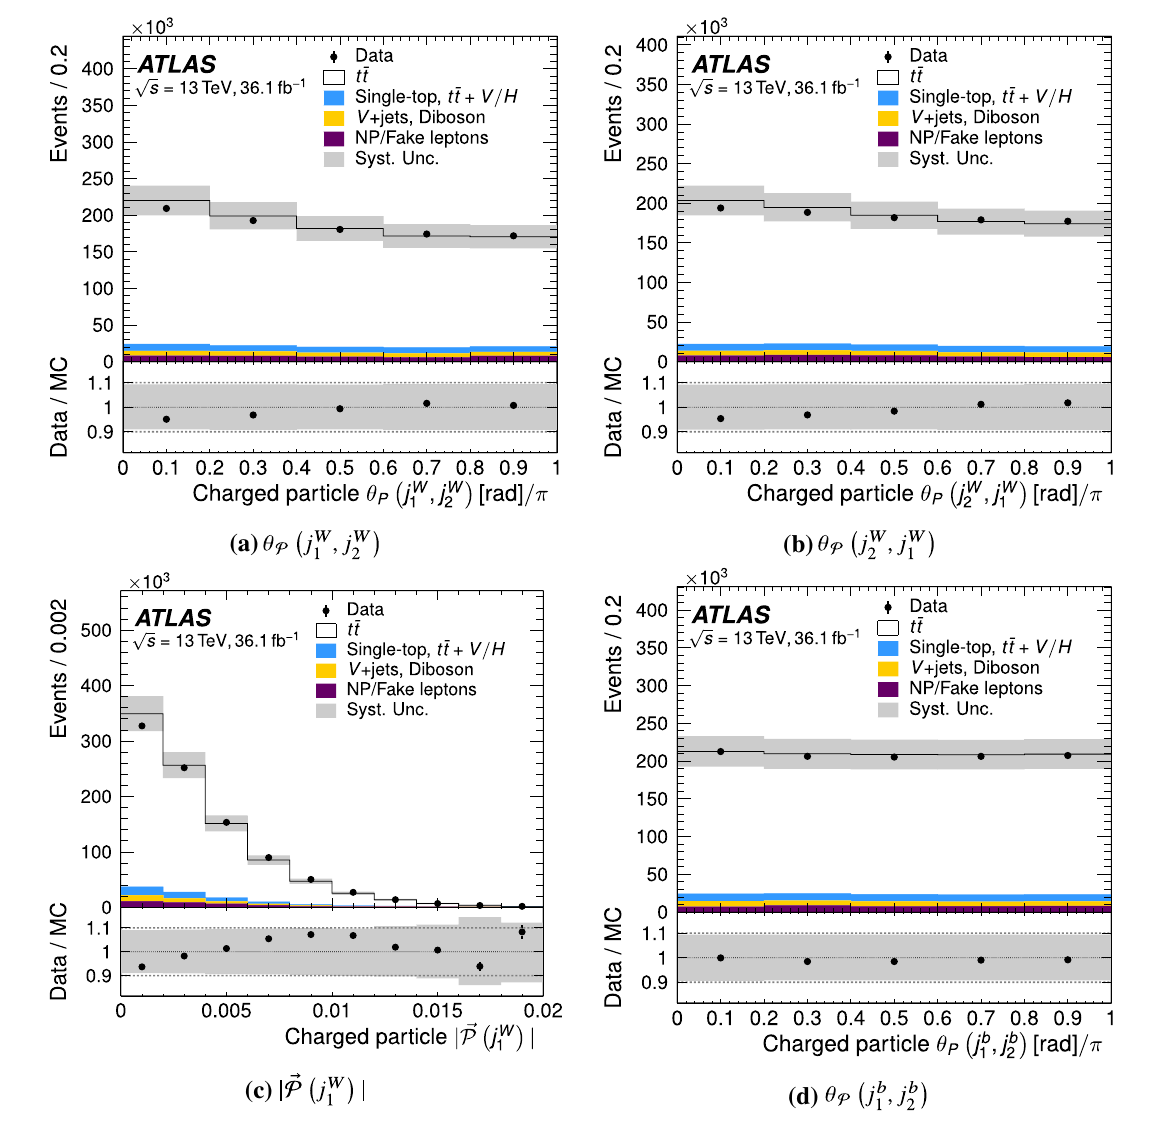
Fig. 4 Detector-leveldistributionsforthefourconsideredobservables: the a forward and b backward pull angle for the hadronically decay- ing W boson daughters, c the magnitude of the leading W daughter’s jet-pull vector, and d the forward di- b -jet-pull angle. Uncertainty bands